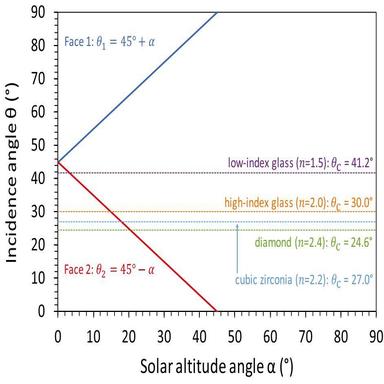
Angles of incidence on faces 1 and 2 in the vertical retroreflector system) when downwelling beam sunlight strikes face 1 and beam light reflected from face 1 strikes face 2. Shown for reference are the critical angles for various clear windows in air; total internal reflection will occur only when incidence angle θ exceeds critical angle c.